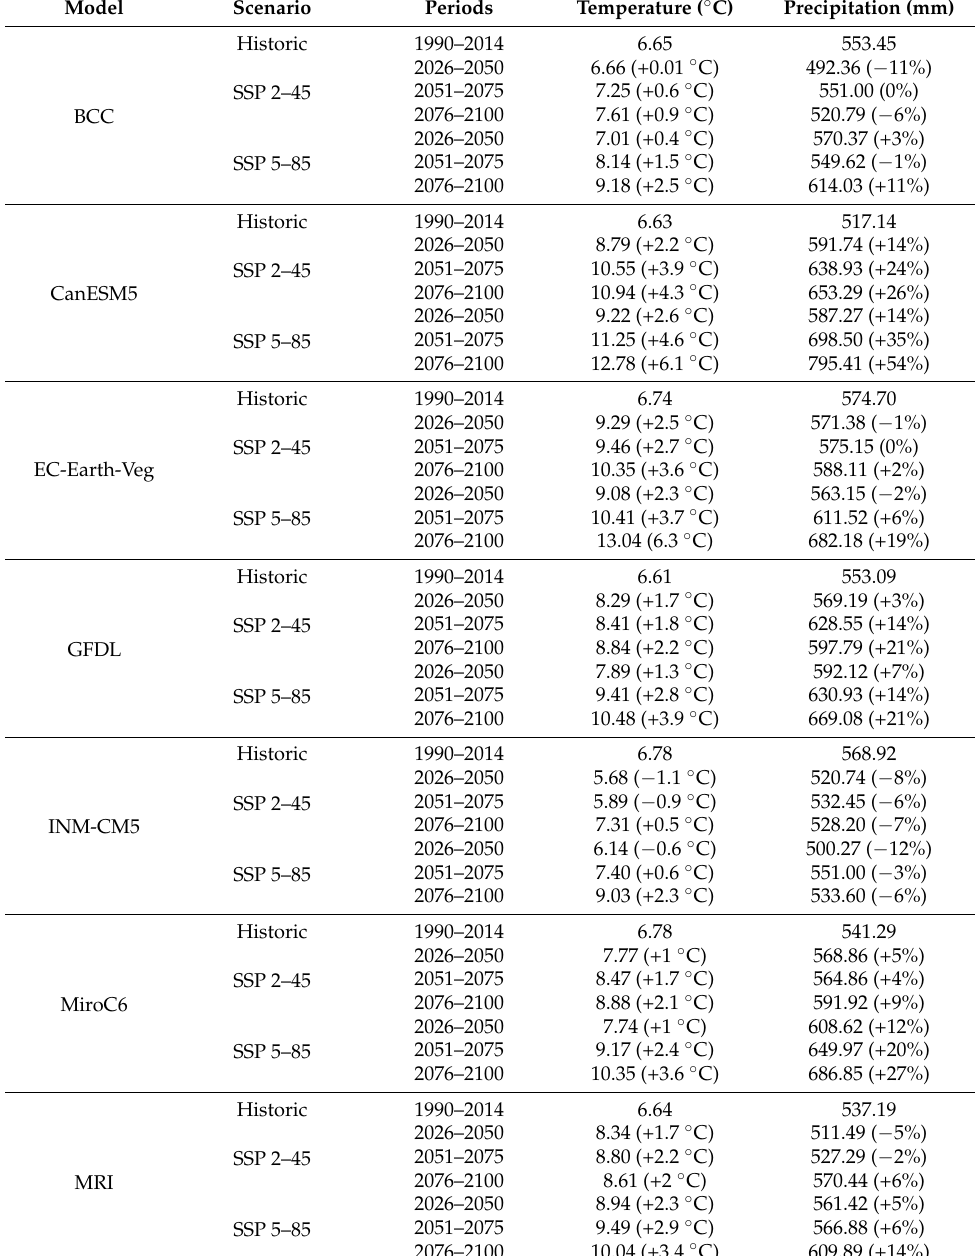
Table 5. Historical and projected annual average precipitation and temperature data for the Erken basin for each